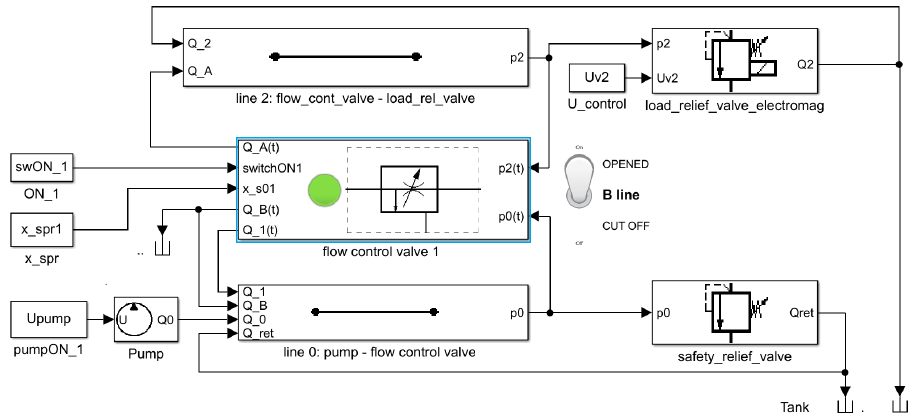
Figure 12. Model of hydraulic system in